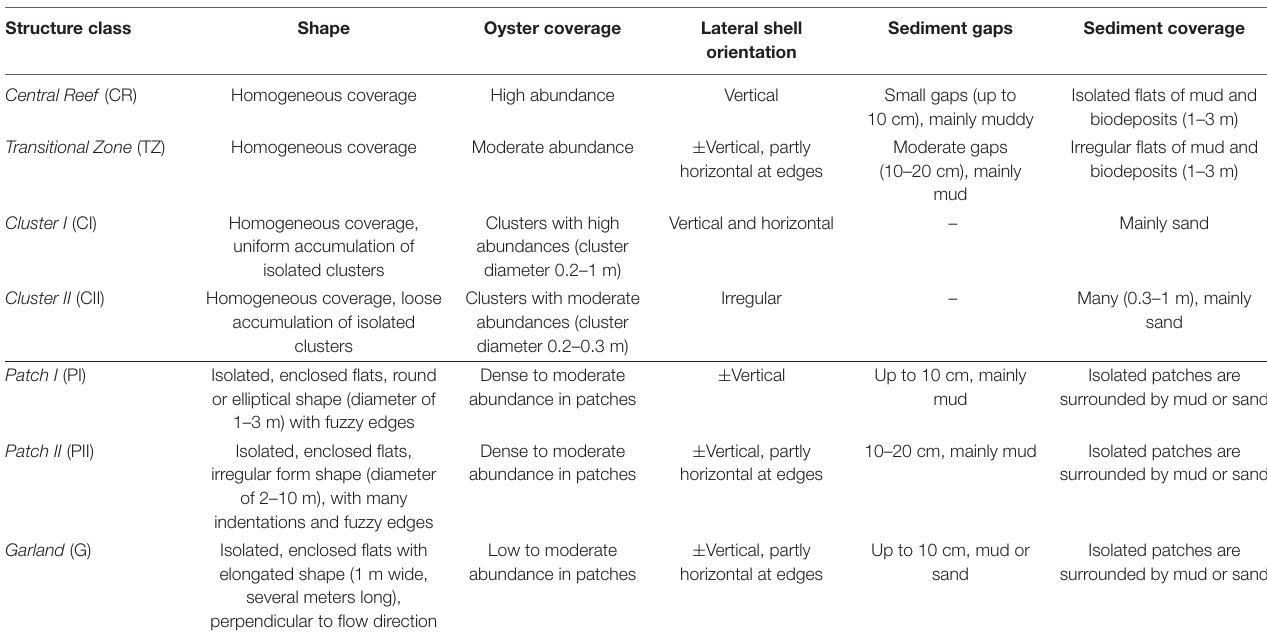
FIGURE 3 | Examples of the proposed structural classes found during the initial observation phase at the study site: Central Reef , Transitional Zone , Cluster I , Cluster II , Patch I , Patch II , and Garland . The gray frame illustrates 1 m 2 . TABLE 1 | Descriptive parameters of the proposed structural